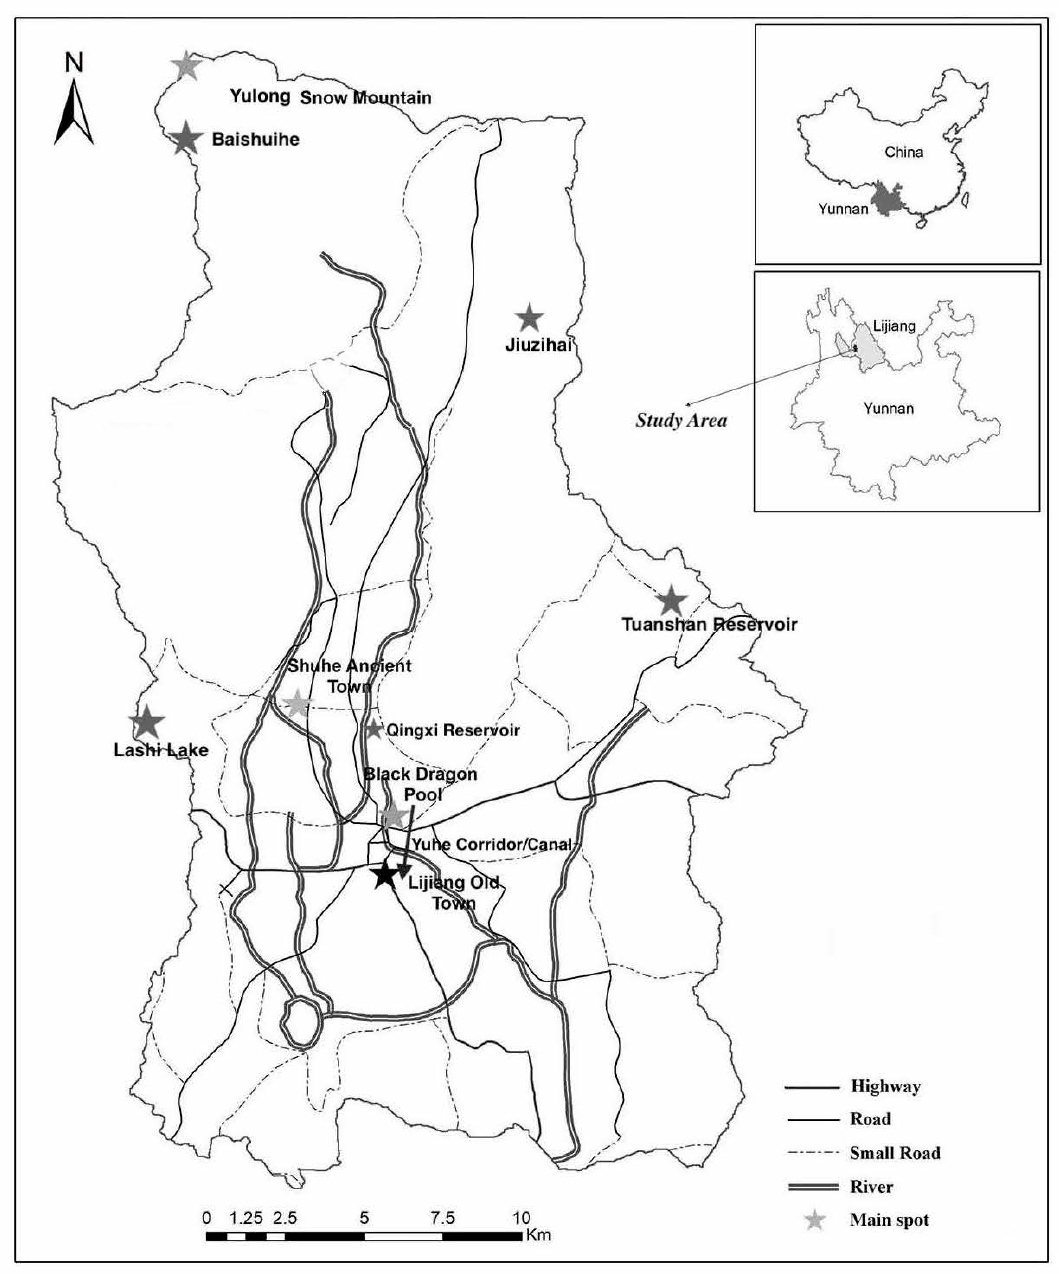
Figure 3. Map of the study site.